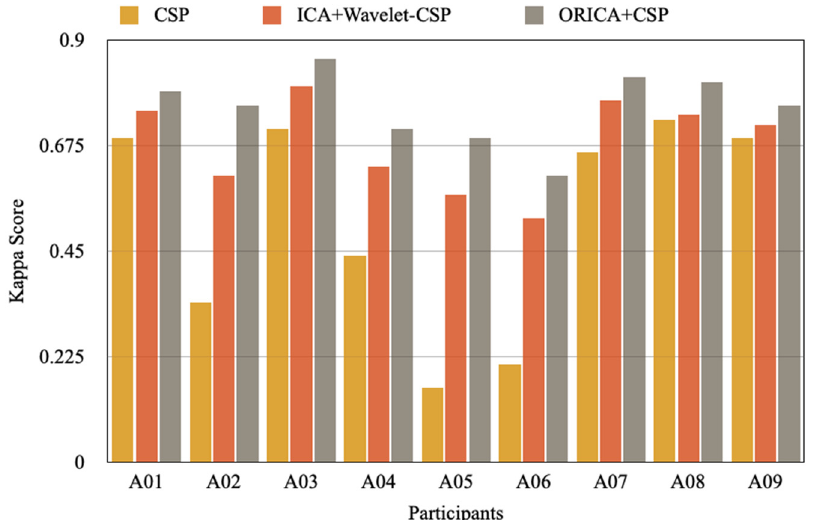
Figure 8. Performance comparison in terms of Cohen’s Kappa coefficient.